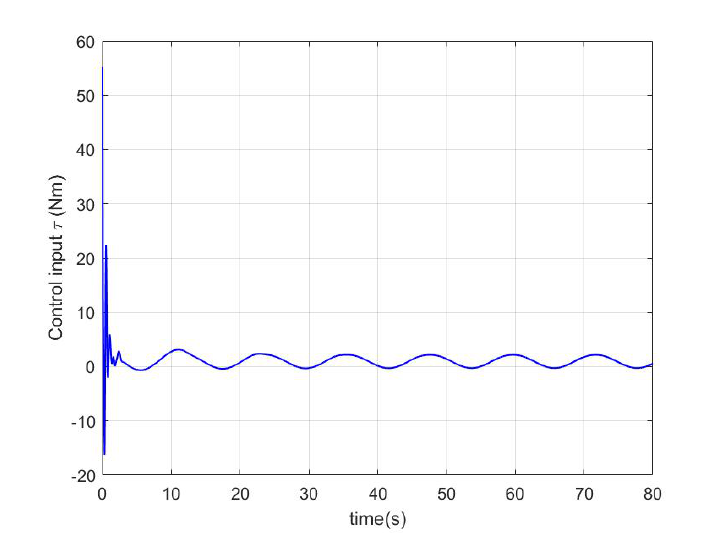
Figure 6. The control input of (17) in Case